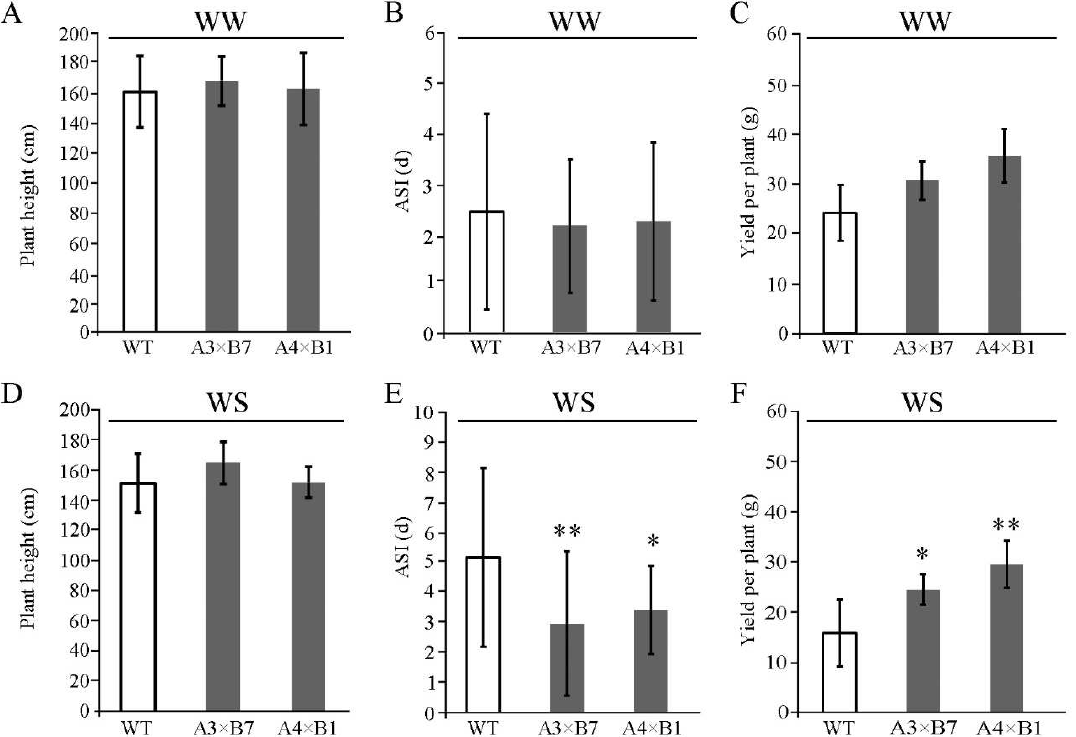
Figure 4. Transgenic and WT maize drought response under field conditions. Statistical analysis of ( A ) plant height, ( B ) ASI, and ( C ) yield per plant for each line under well-watered conditions from May to September 2019 in the field. Statistical analysis of ( D ) plant height, ( E ) ASI, and ( F ) yield per plant for each line under drought conditions from May to September of 2019 in the field. At least 8 plants per line were used in each replicate and independently replicated three times. Data are average of three independent tests ± s.d. (* p < 0.05, ** p < 0.01; two-sided t -test).